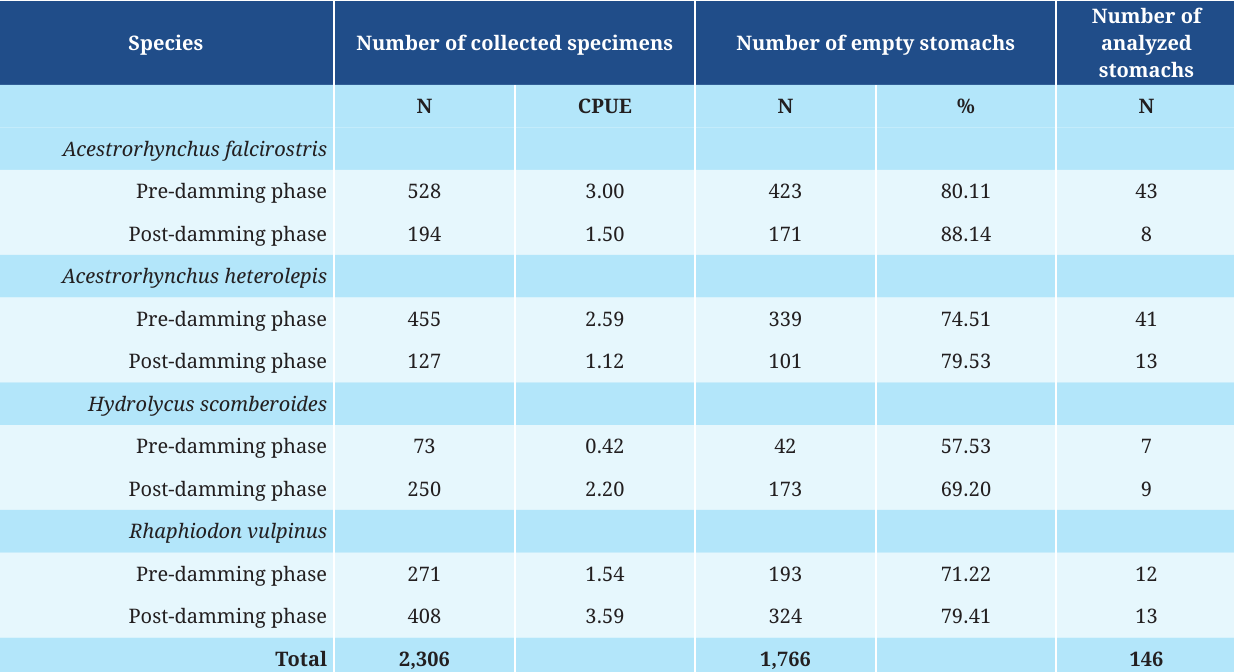
TABLE 1 | Abundance, Capture Per Unit of Effort (CPUE – individuals/10,000m 2 /24h), and the number of empty and analyzed stomachs with alimentary